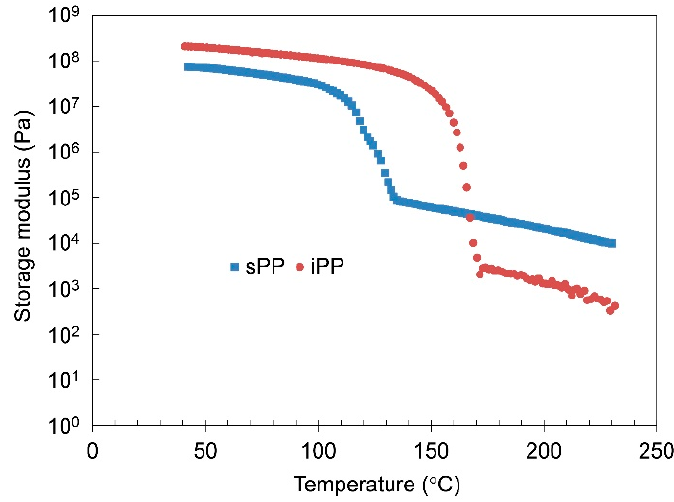
Figure 1. Storage modulus of polypropylene (PP)-solids as a function of temperature.